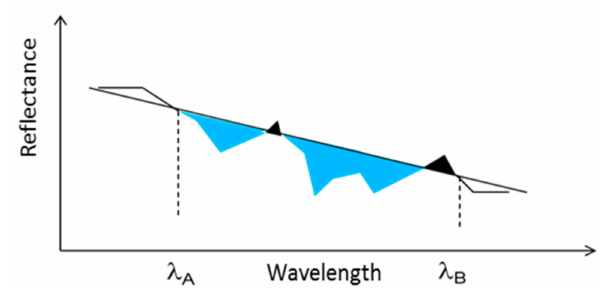
Figure 4. Illustration of the area index (in